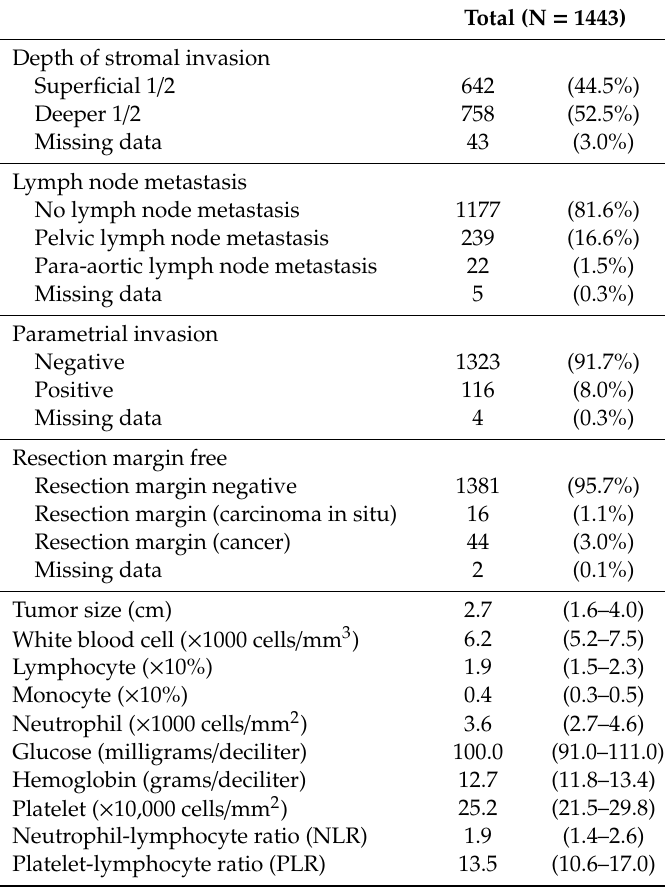
FIGO: International Federation of Gynecology and Obstetrics.